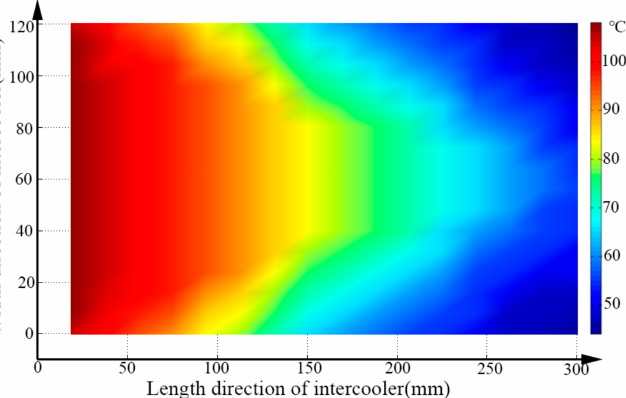
Figure 8. Airside temperature field of single-pass water-cooled charge air cooler.